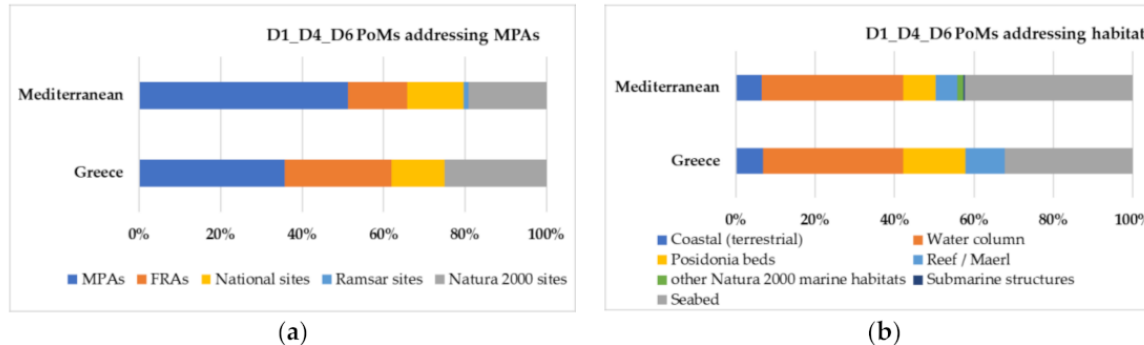
Figure 14. ( a ) Habitats to which the Greek and Mediterranean MS measures apply. ( b ) MPAs to which the Greek and other Mediterranean MS measures